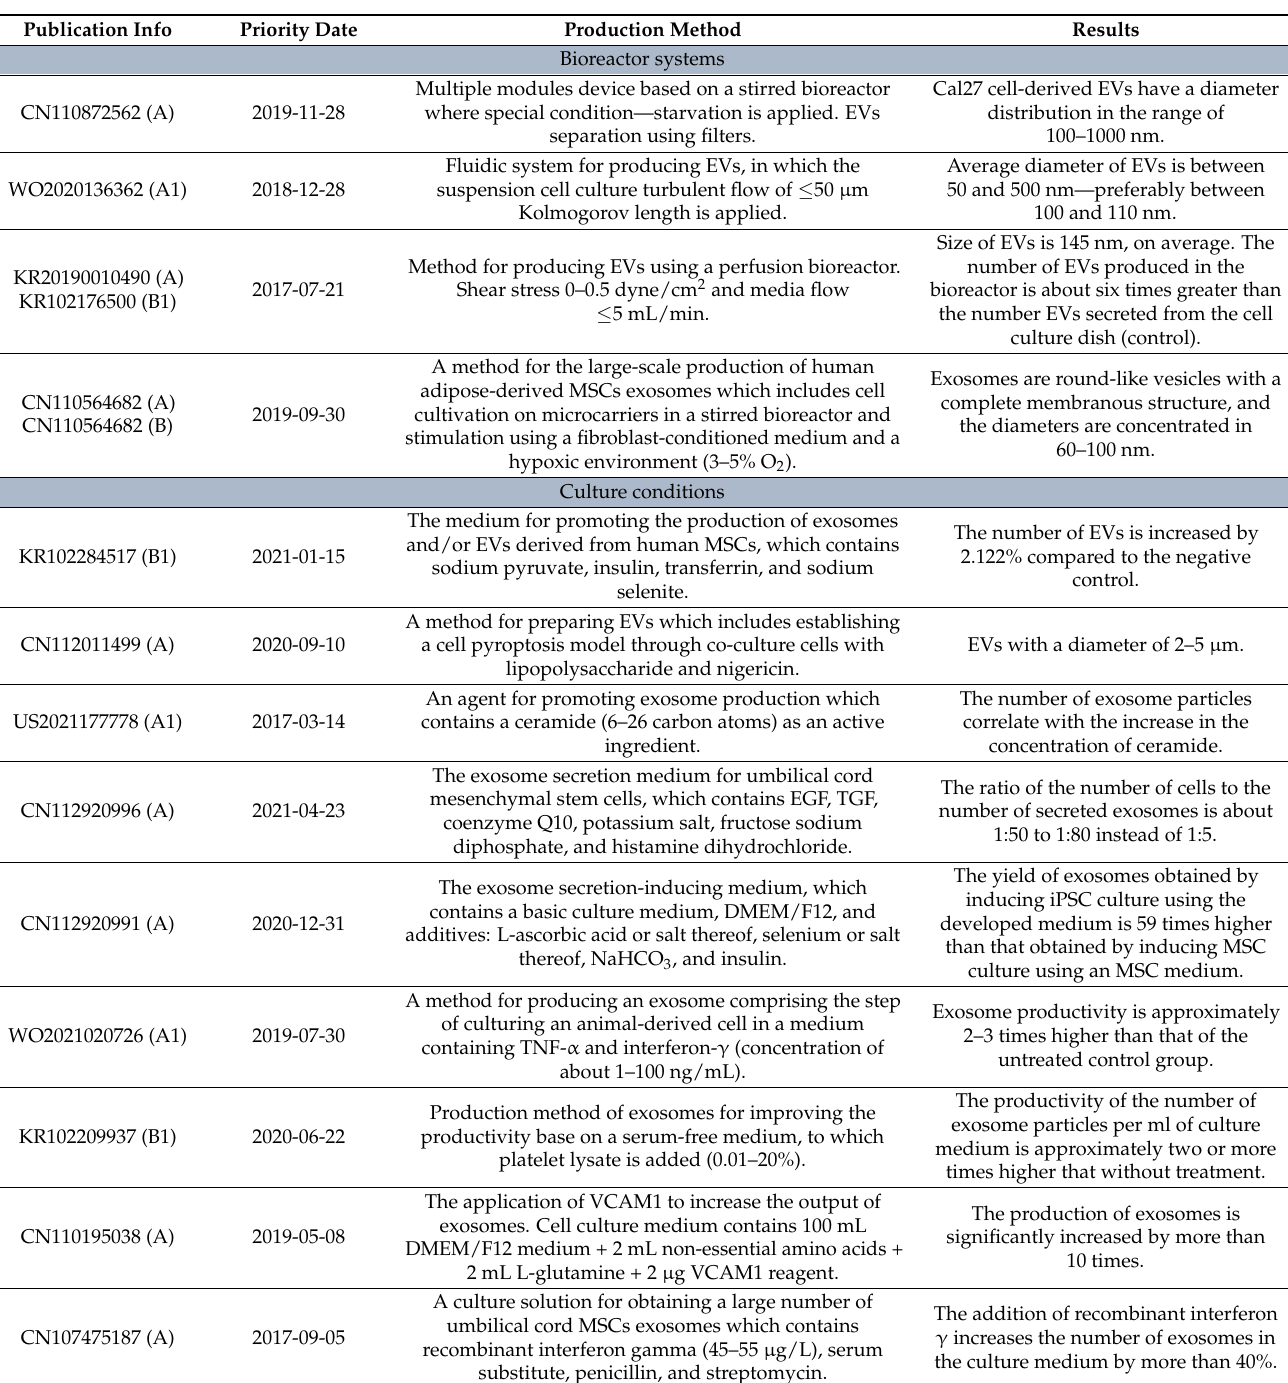
Table 1. Overview of patents related to methods of membrane vesicles